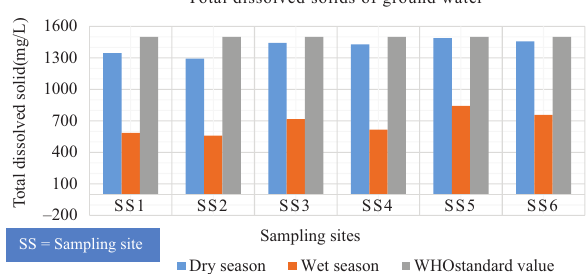
Figure 2 . Seasonal variation in total dissolved solid of